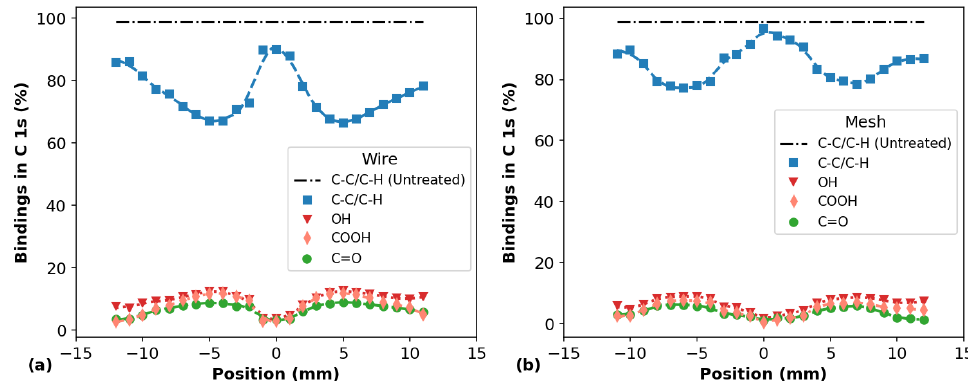
Figure 12. Bindings in C 1 s obtained from XPS measurements on the surface of PP samples for different positions using ( a ) the wire mounting and ( b ) the mesh